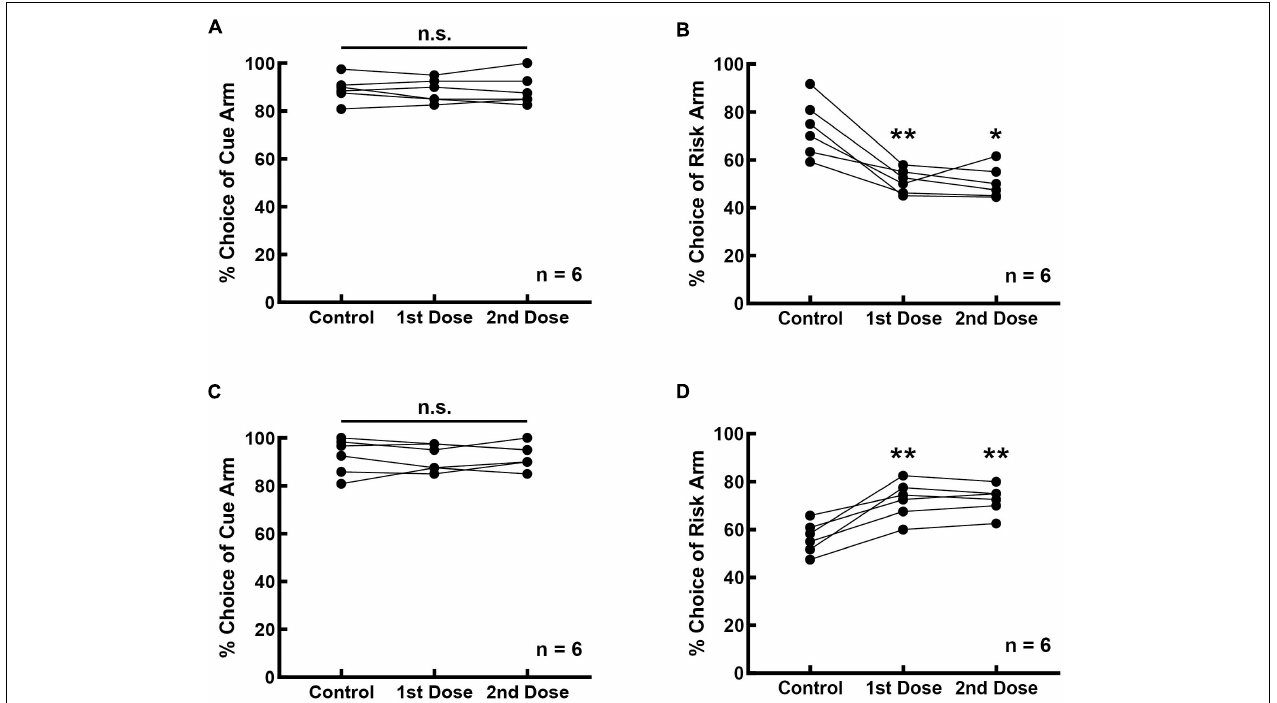
FIGURE 3 | Prefrontal D1 receptors are involved in regulating cue-guided RDM behavior. (A) Bilateral infusion of the D1 antagonist SCH-23390 into the mPFC did not affect rats’ performance in the cue-test blocks. (B) Risk selection in the free-choice block was reduced upon inhibition of D1 receptors in the mPFC. (C) Bilateral infusion of the D1 agonist SKF-82958 into the mPFC did not affect rats’ performance in the cue-test blocks. (D) Risk selection in the free-choice block increased upon stimulation of D1 receptors in the mPFC. * p < 0.05; ** p < 0.01.